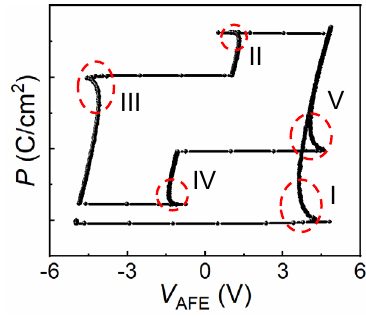
Fig. 4 Relation between polarization and voltage. The numbers correspond the transition